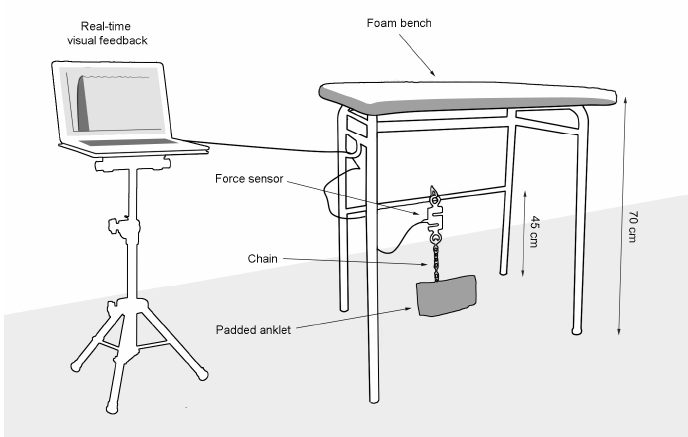
Figure 1. Isometric knee extension test set-up. The portable strain gauge secured at one end to the ankle. Visual feedback was given in real time using a computer